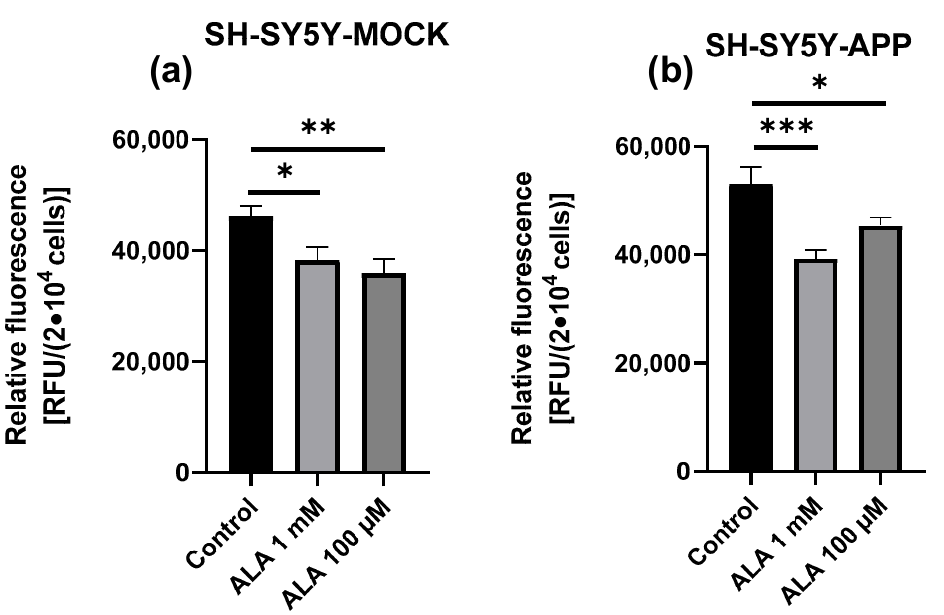
Figure 5. Effect of alpha lipoic acid (ALA) on ROS production in SH-SY5Y-APP and MOCK cells. ROS production of SH-SY5Y-MOCK cells ( a ) after 24 h incubation with 100 µ M ALA or 1 mM ALA, ethanol served as a control in both cases. ROS production of SH-SY5Y-APP cells ( b ) after 24 h incubation with 100 µ M ALA or 1 mM ALA, ethanol served as a control in both cases. Data are displayed as the means ± SEM. N = 8. Statistical significance was tested via one-way ANOVA and Tukey’s post-hoc test (*** p < 0.001, ** p < 0.01 and * p < 0.05).